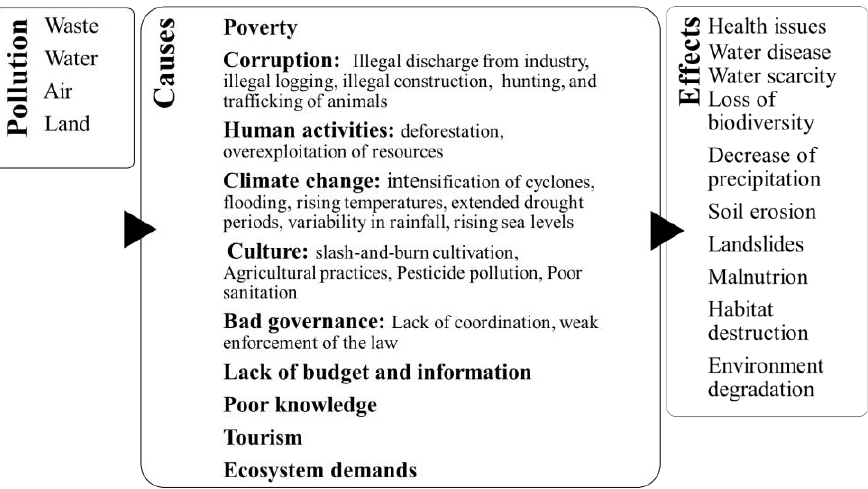
Figure 4. Example of major causes and effects of environmental degradation in Madagascar (Source: Authors).